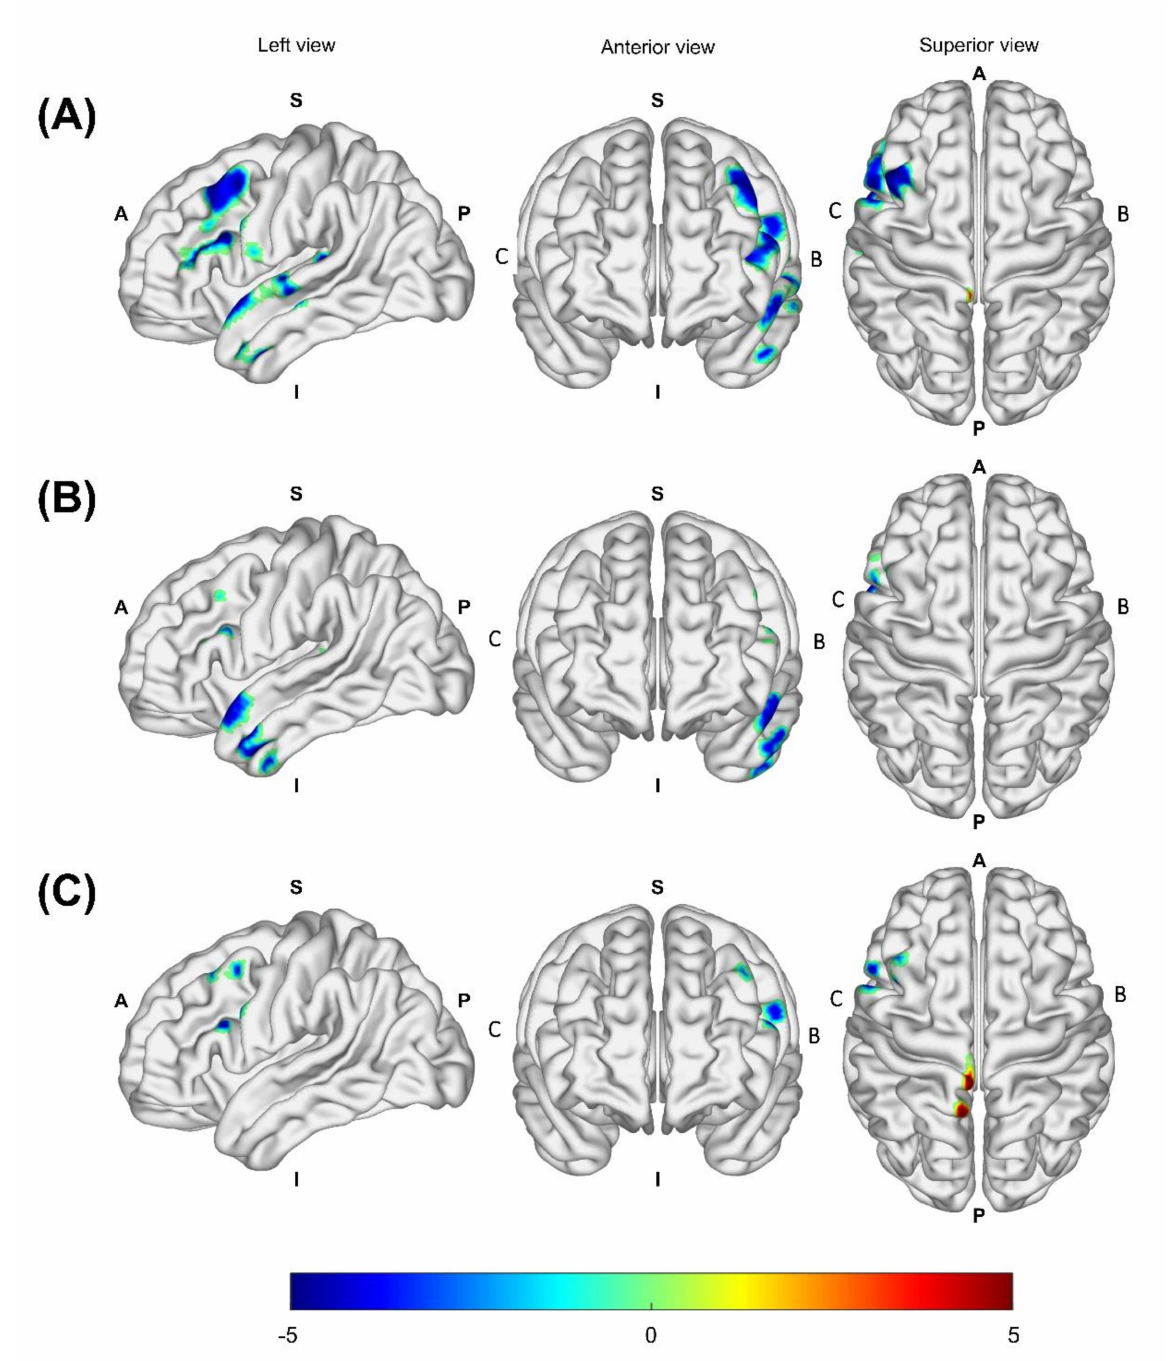
Figure 1. Mapping of patients’ versus controls’ CBV status as adjusted for sex and age. The CBV was measured as an increase and decrease in the pain and motor network including postcentral gyrus, frontal lobe, temporal lobe, and insula in the hemisphere associated with burned limbs in all burn patients ( A ). In the EB group, the CBV was decreased in the pain and motor network including the frontal and temporal lobe in the hemisphere associated with burned limbs ( B ). In the NEB group, the CBV was measured as an increase and decrease in the pain and motor network including the postcentral gyrus, precentral gyrus, and frontal lobe in the hemisphere associated with burned limbs ( C ). Areas with increased CBV are red-yellow and areas with decreased CBV are blue-light blue. Abbreviations: CBV, cerebral blood volume; EB, electrical burn; NEB, non-electrical burn; B, hemisphere associated with burned limb; C, hemisphere associated with contralateral intact limb; A, anterior; P, posterior; S, superior; I,